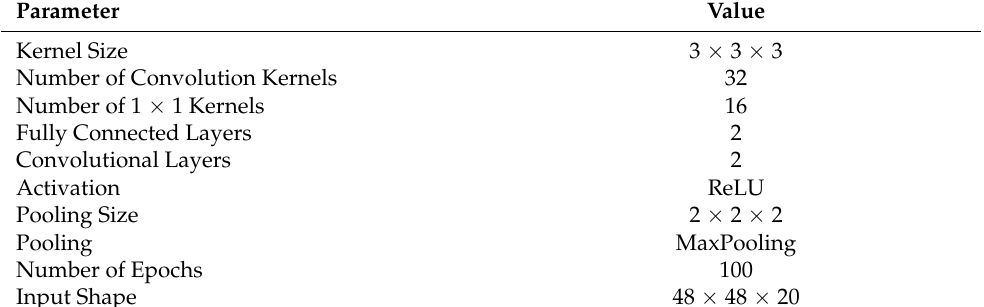
Table 1. Summary of the network parameters used during model training.